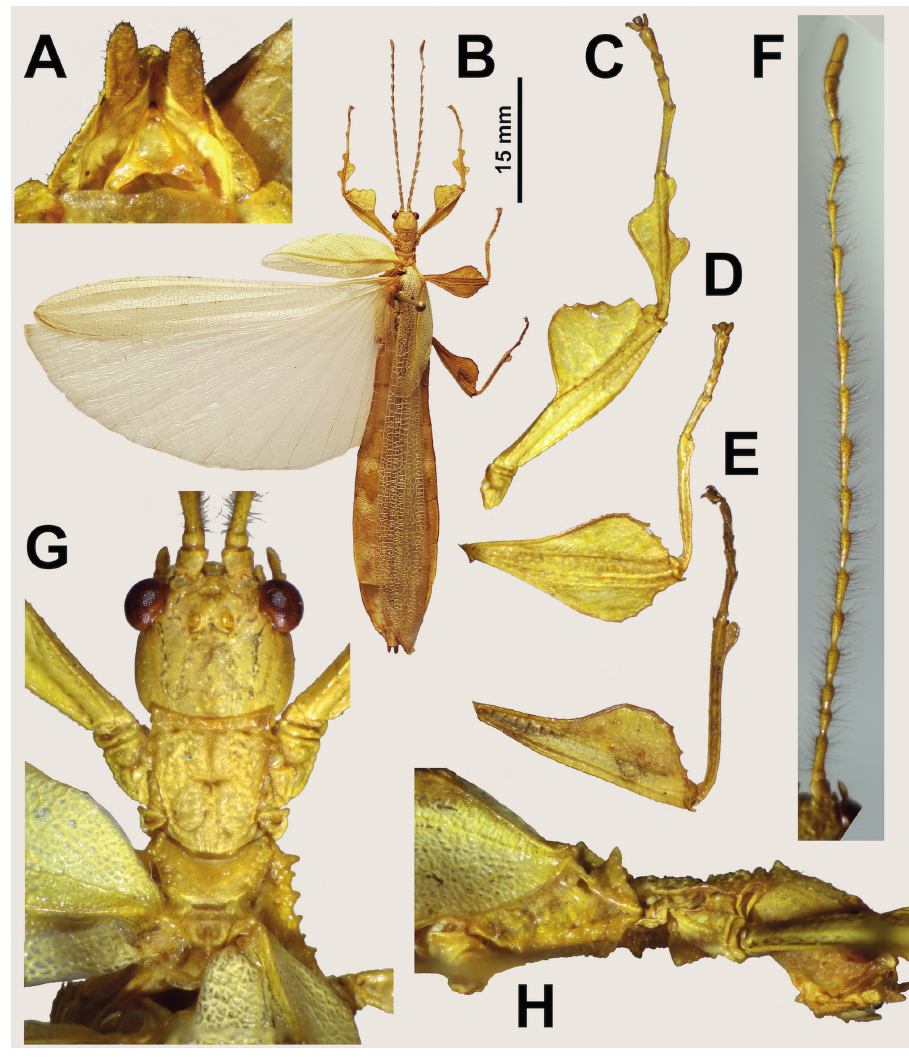
Figure 12. Holotype male Vaabonbonphyllium rafidahae gen. et sp. nov., (IMQC) (Coll RC 19-106) photographs by the first author A genitalia, ventral B habitus, dorsal C details of the protibial and pro- femoral lobes D details of the mesotibial and mesofemoral lobes E details of the metatibial and metafemo- ral lobes F antenna, dorsal G details of the head and thorax, dorsal H head–thorax, lateral. Scale bar only associated with B